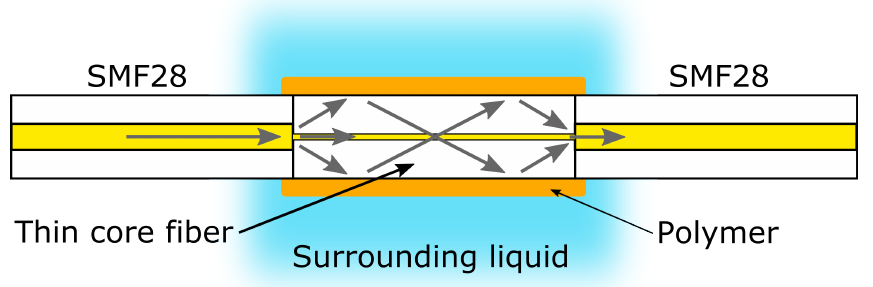
Figure 1. Principle of a single mode-multi mode-single mode (SMS) thin core Mach-Zehnder interferometer. Light from the core of the left SMF28 fiber is coupled to cladding modes in the short (TCF), which can interact with the surrounding liquid depending on the liquid refractive